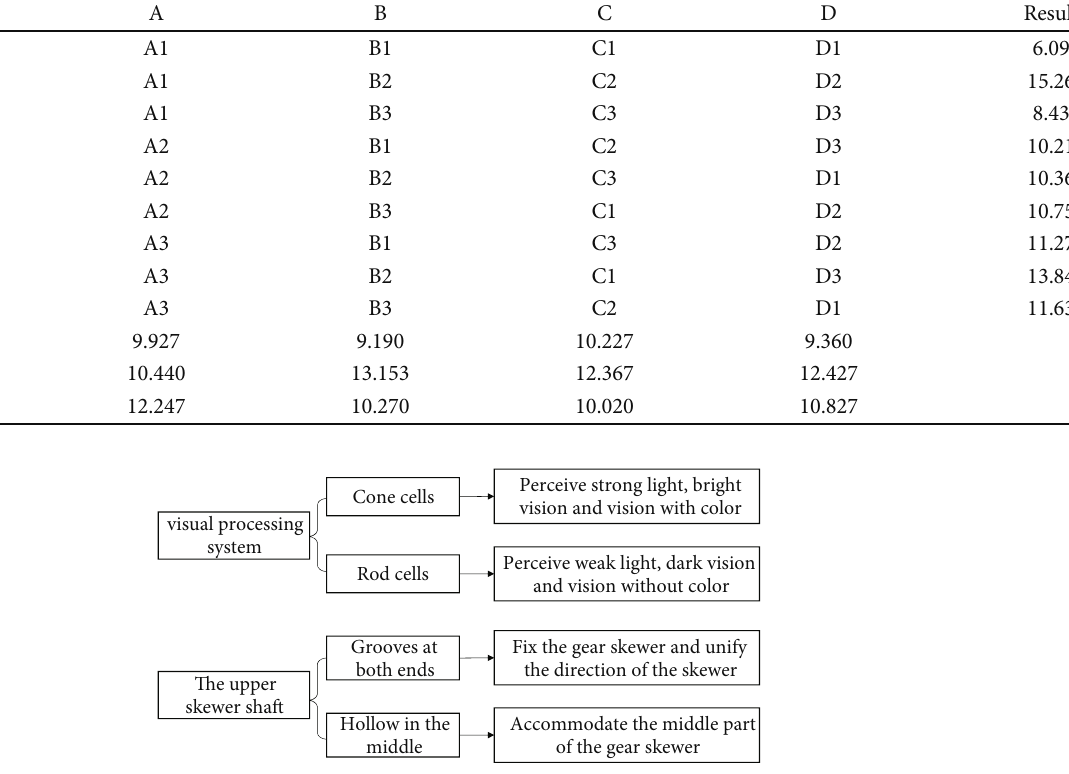
Figure 8: The schematic diagram of the biotechnology system transformation of the upper skewer structure.